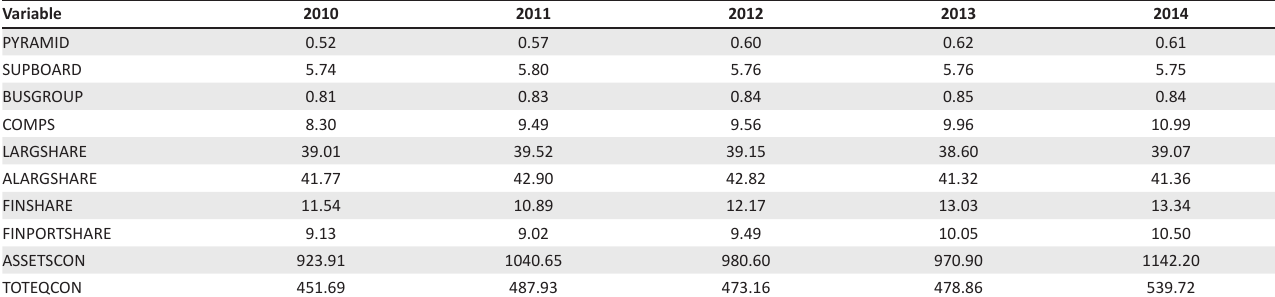
TABLE 2: Value of variables used in the